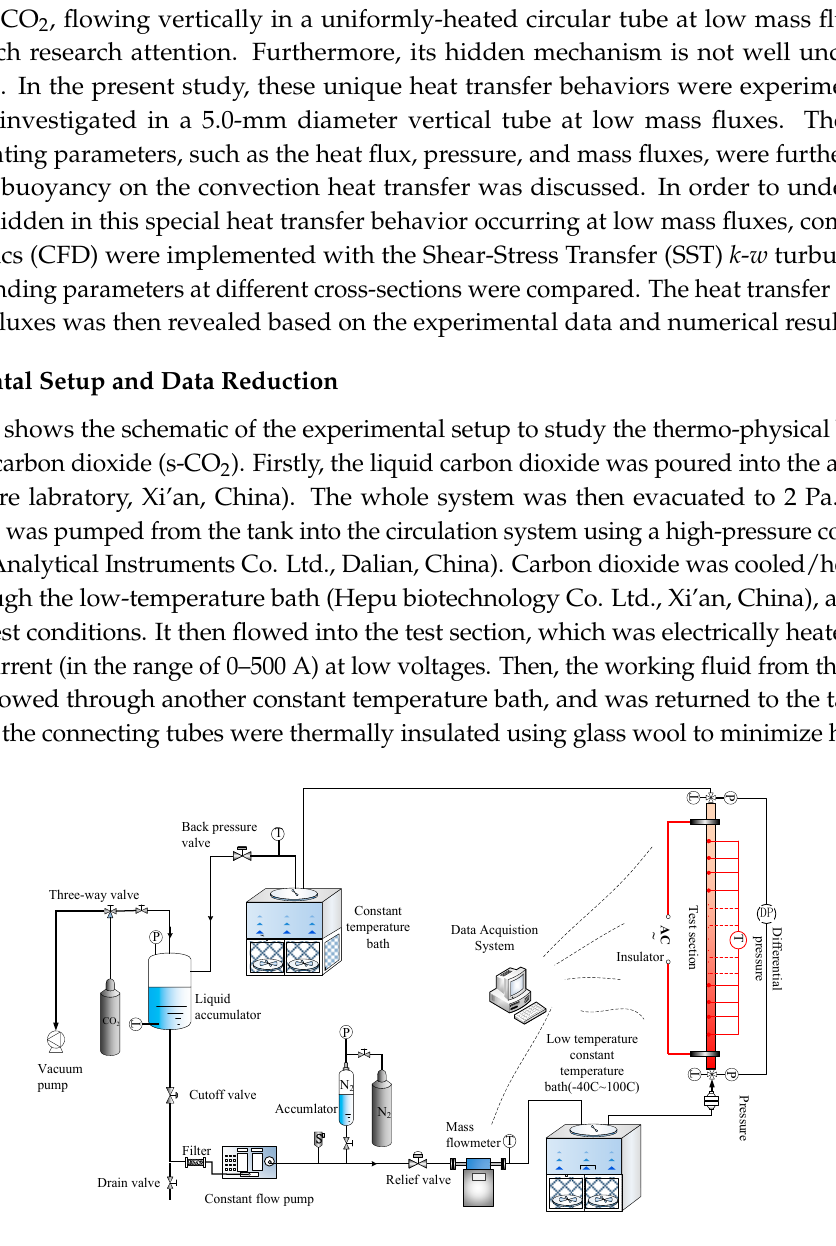
Figure 4. Schematic of the experimental setup used to study the heat transfer behavior of Supercritical carbon dioxide (s-CO 2 ). AC: Alternating Current; DAS: Data Acquisition System.